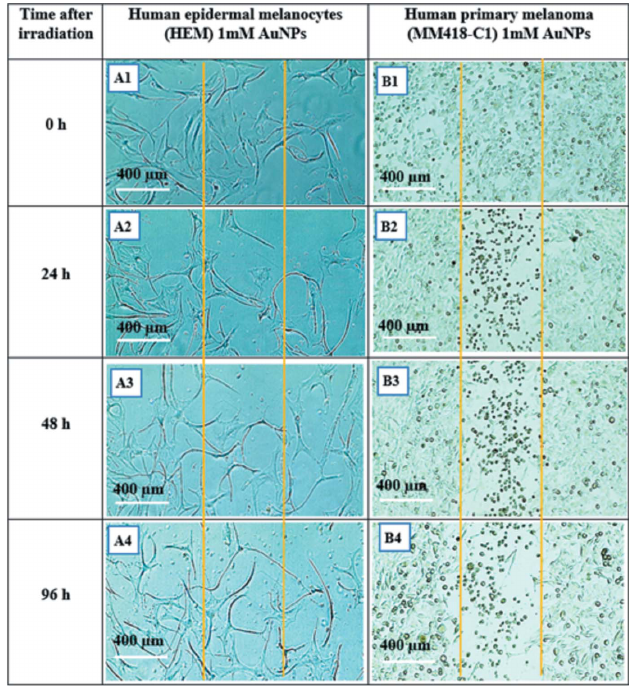
Figure 13 Human epidermal melanocytes HEM and human primary melanoma MM418-C1 monolayer 24 h after being exposed to 1000 Gy 90 kVp SBB (width 500 m m). Both cell types are treated with 1 m M AuNPs. The boundaries of the radiation fields are marked with orange lines. (A1) HEM immediately after exposure, (A2) 24 h, (A3) 48 h and (A4) 96 h after exposure. (B1) MM418-C1 immediately after exposure, (B1) 24 h, (B2) 48 h and (B4) 96 h after